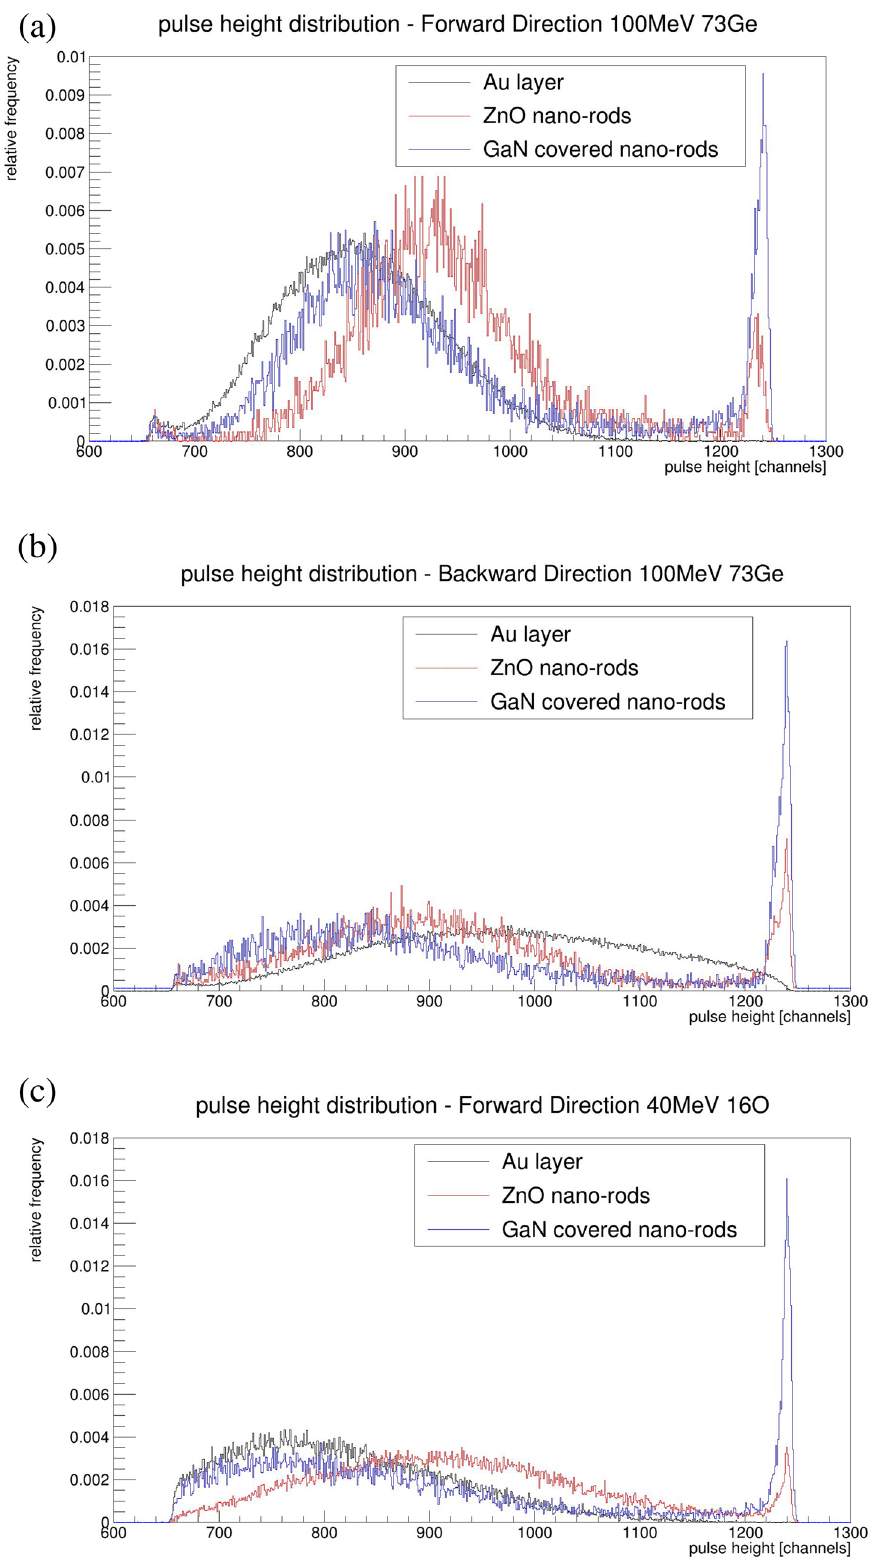
Figure 3. Pulse height distribution for gold and the nano-structured materials under bombardment of 73 Ge at ~ 1.4 MeV/u. In ( a ) the SEE in the forward direction is shown with an MCP bias at − 1550 V. In ( b ) it is shown in a backward direction with a bias of − 1650 V. SEE in the forward direction is shown with a 16 O-beam at 2.5 MeV/u in ( c ). MCP bias was set to − 1700 V in ( c